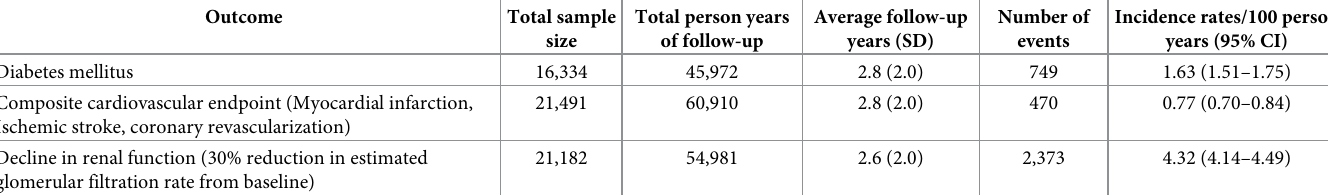
Table 2. Incidence rates for the outcome events of interest in gout patients, Clinformatics ™ Datamart 2004–2015.